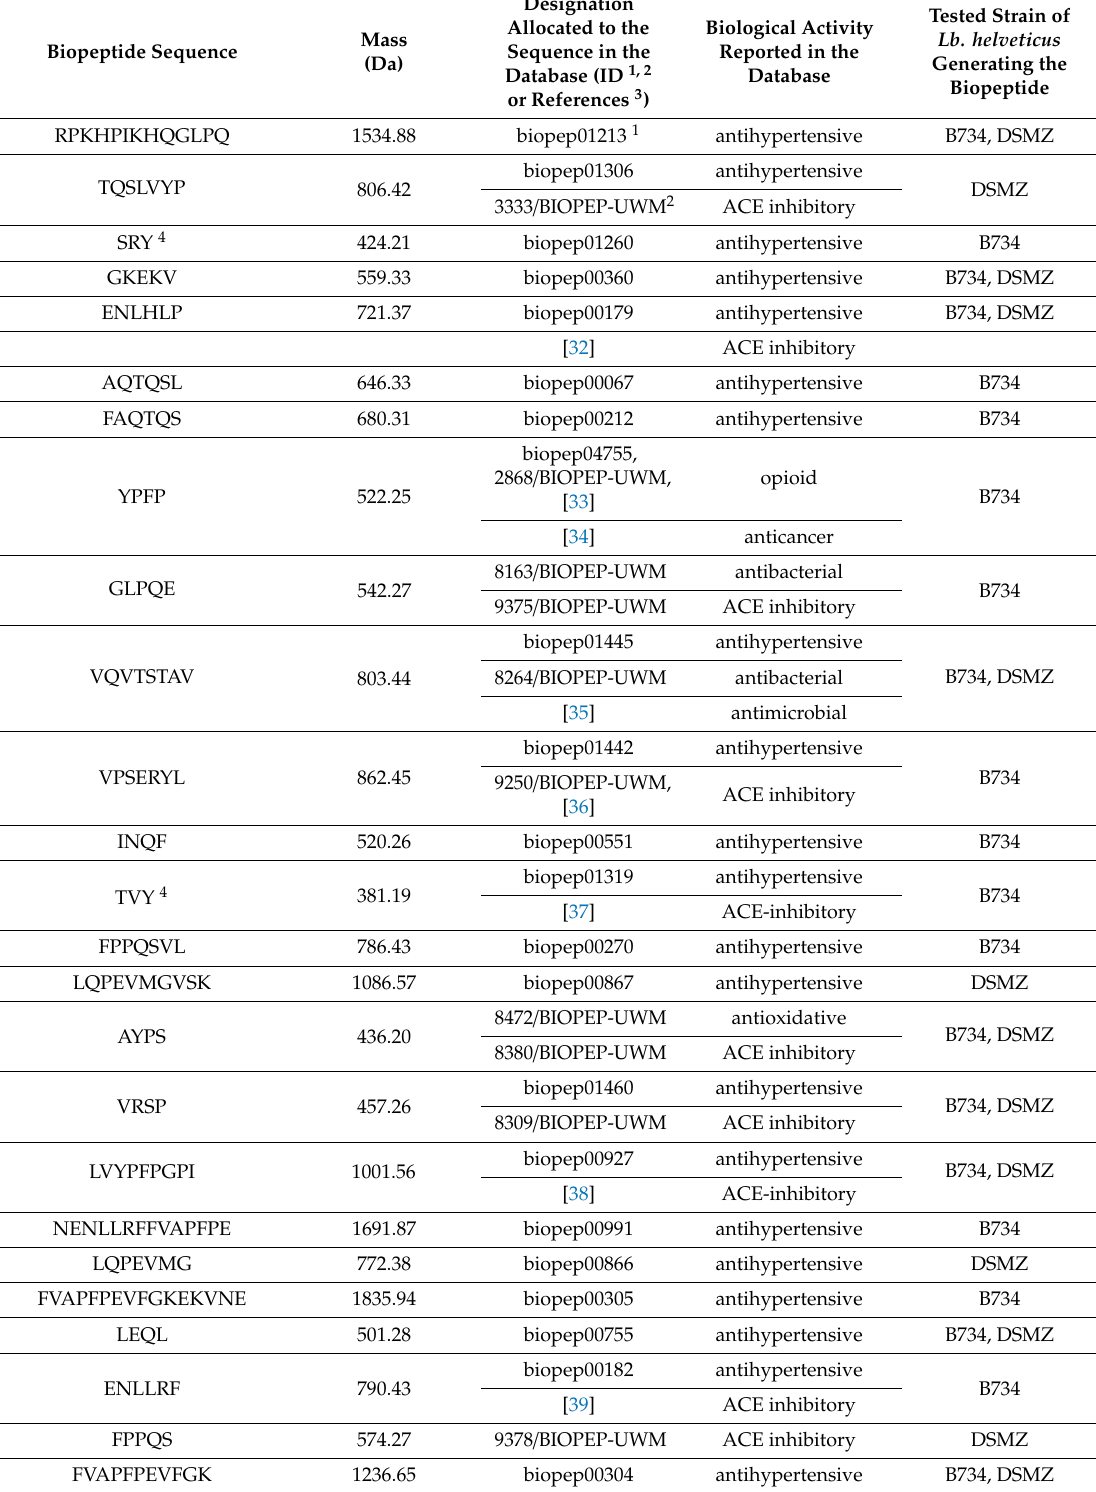
Table 3. Sequences of biopeptides detected in the hydrolysates of the tested whey protein preparation.